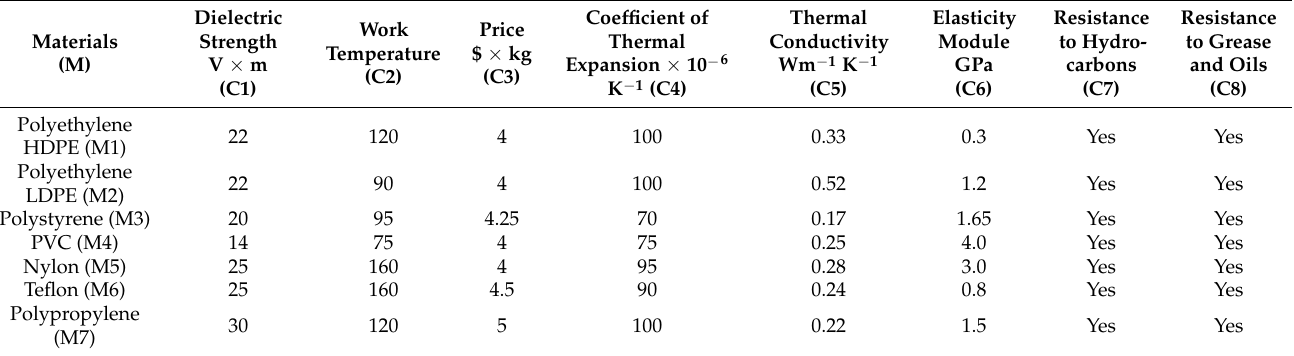
Table 1. Selected materials and their